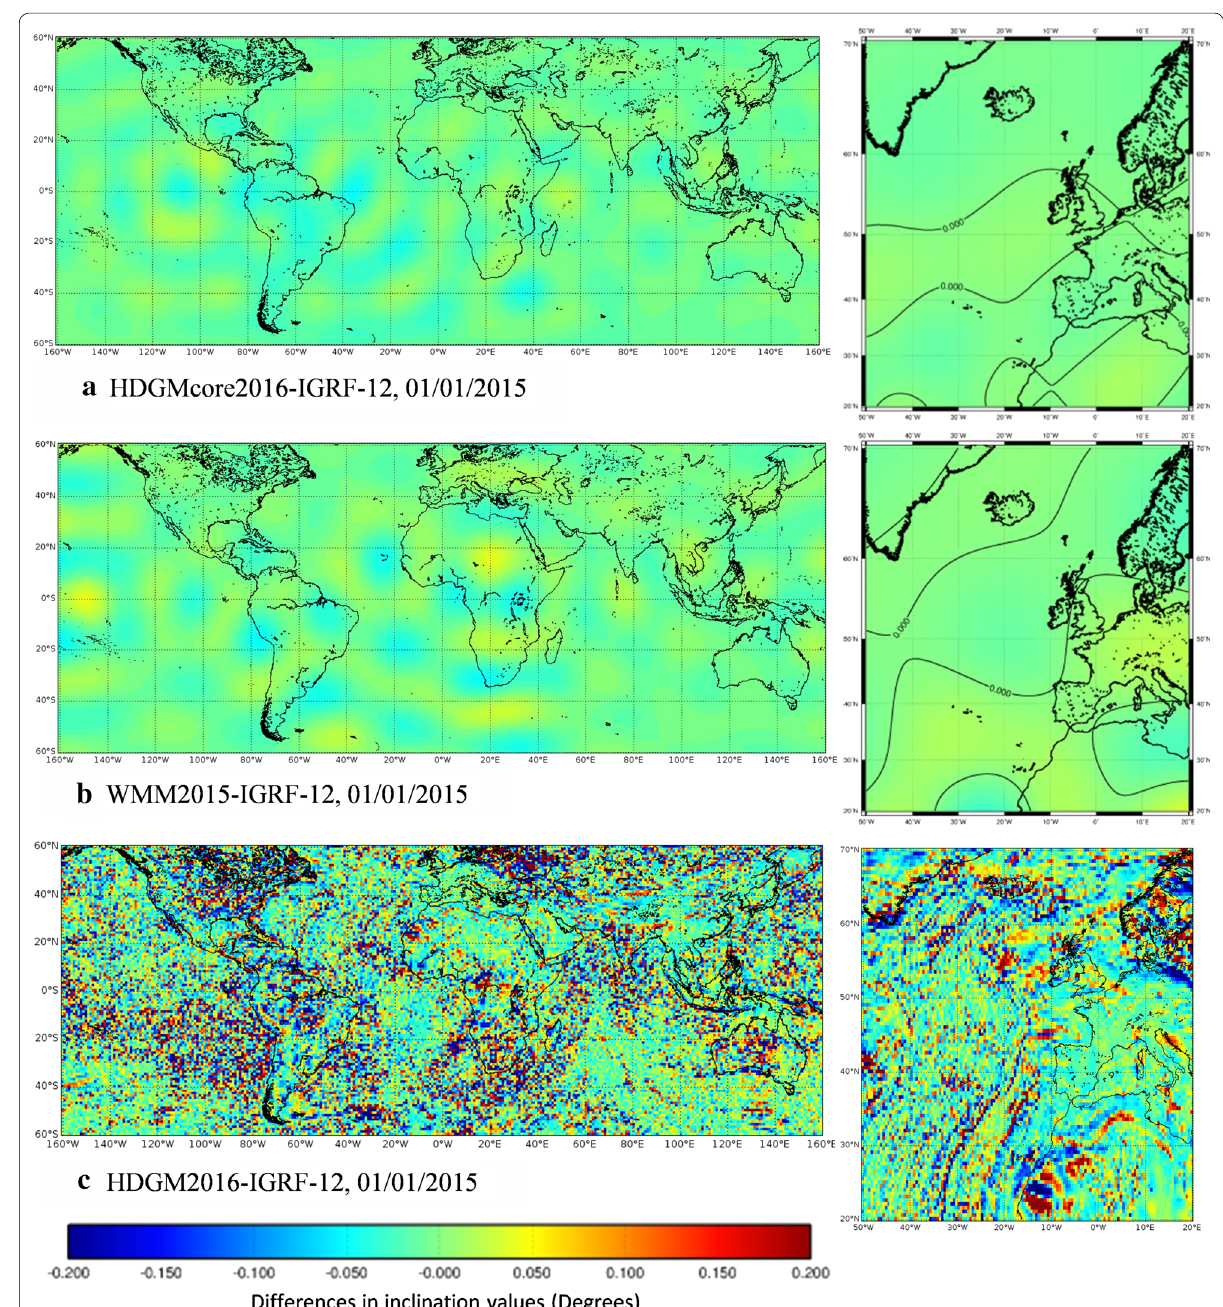
Fig. 4 Maps of differences in inclination values estimated from HDGM2016core ( a ), WMM2015 ( b ), HDGM2016 ( c ) and IGRF‑12 (reference) models at a global scale reduced by 30° in latitude and 20° in longitude (left, grid spacing: 1°) and for the NEAWM area (right, grid spacing: